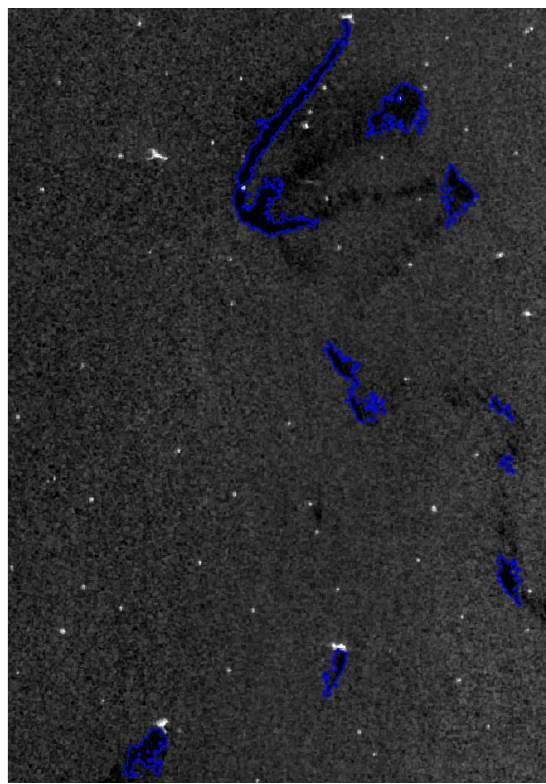
Figure 4: Output vector overlaid on input for dark region extraction from ocean using the proposed tool